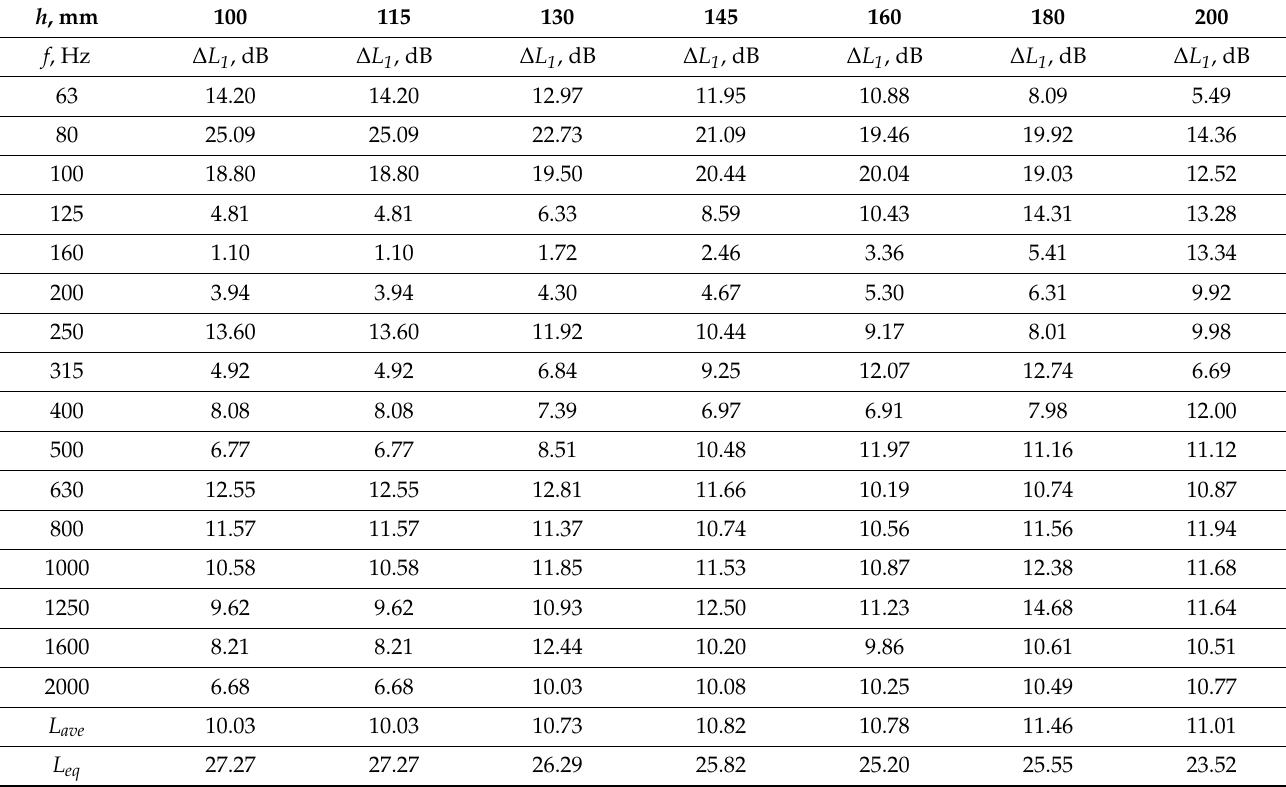
Table 3. Results for calculations for ∆ L 1 at third-octaves for area 1 at a/b = 2.6.